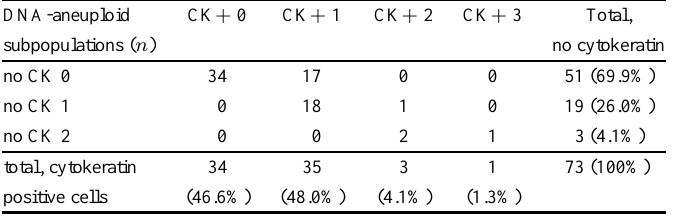
Table 4 Endometrial cancer. Detection of DNA-aneuploid subpopulations dependent on gat- ing of cytokeratin positive